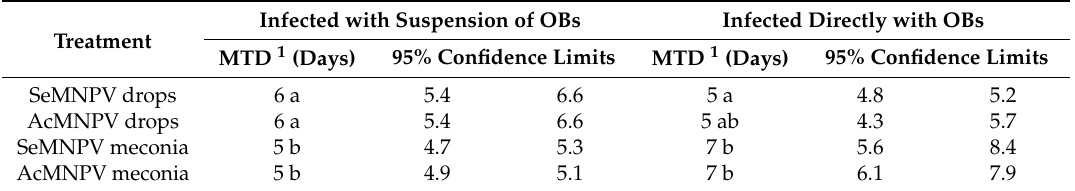
Table 2. MTD (Median Time to Death) values estimated in S . exigua second instars infected with suspensions of OBs or directly with predator’s excreta. Infected with Suspension of Treatment